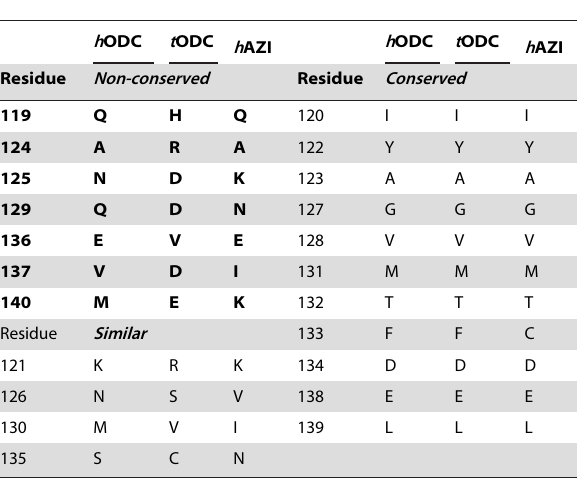
Table 1. Amino acid residues at the putative AZ-binding site of human ODC ( h ODC), Trypanosoma brucei ODC ( t ODC) and human AZI ( h